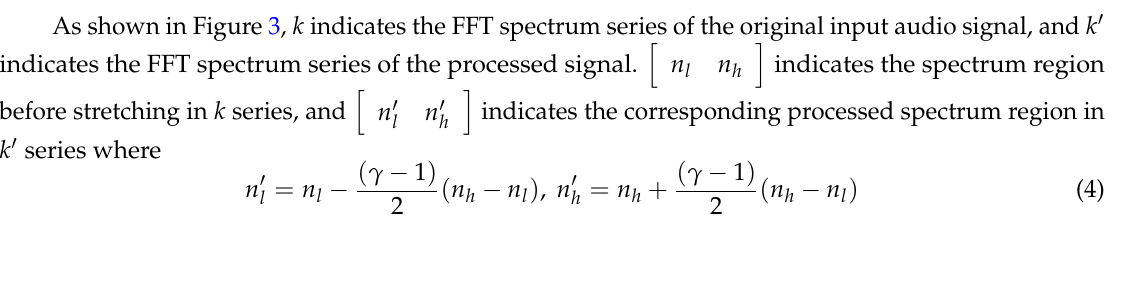
Figure 2. Piecewise-linear frequency shifting unit in the digital hearing aids. ADC, analog to digital converter; DAC, digital to analog converter; AGC, automatic gain control; FFT, fast Fourier transform; IFFT, inverse fast Fourier transform.